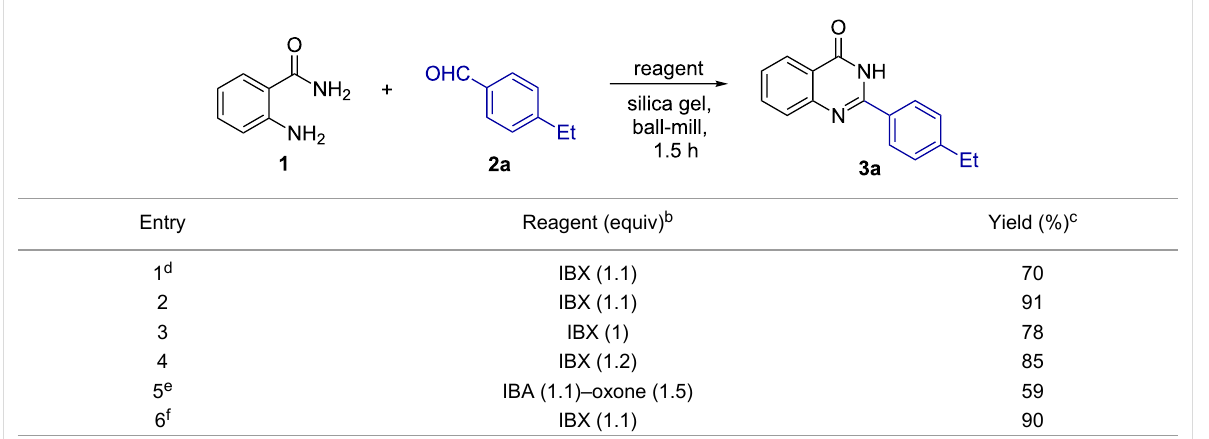
Figure 2: Comparison of the current work with the existing literature reports.